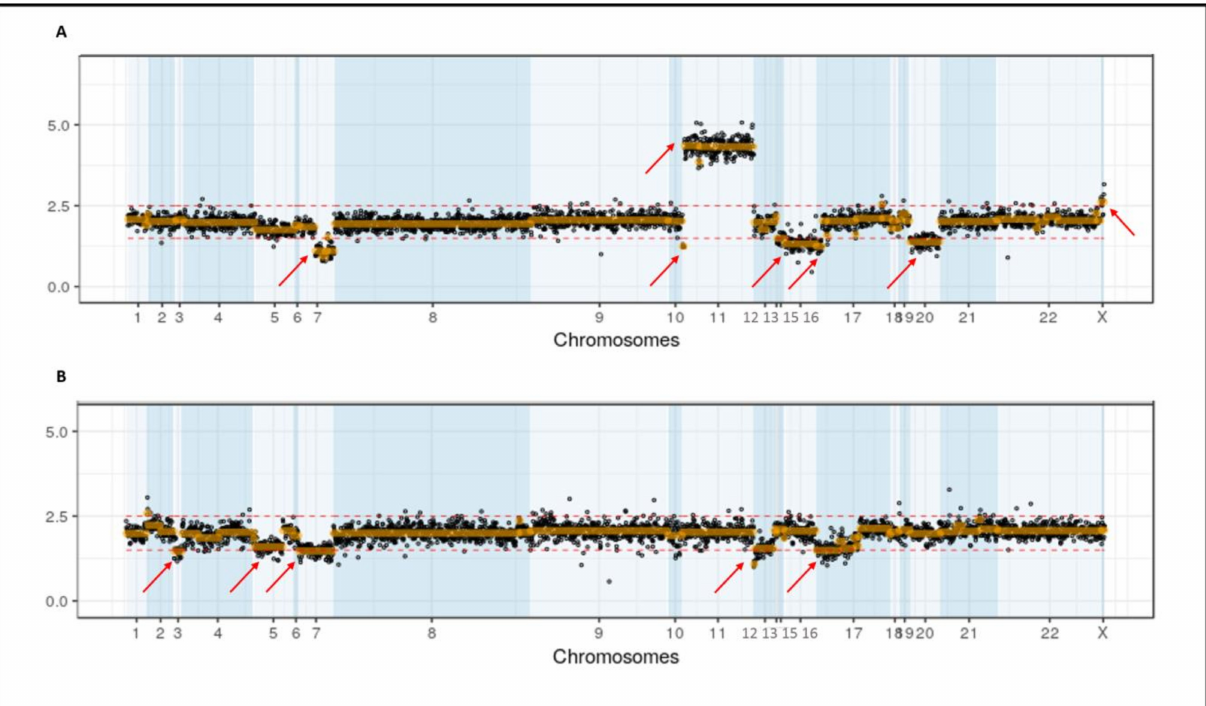
Figure 3. CNV diagram of two patients with more than three CNV alterations: Diagram represented all regions covered sorted by chromosome. CNV gains were considered over 2.5 and CNV losses bellow 1.5. ( A ) CNV diagram of PN 97, who showed a normal karyotype in less than 15 metaphases, which shows seven CNV alterations (arrows), three of them were detected also by routine FISH. ( B ) CNV diagram of PN 60, who did not have an available karyotype, showing five CNV alterations, four of them detected also by routine